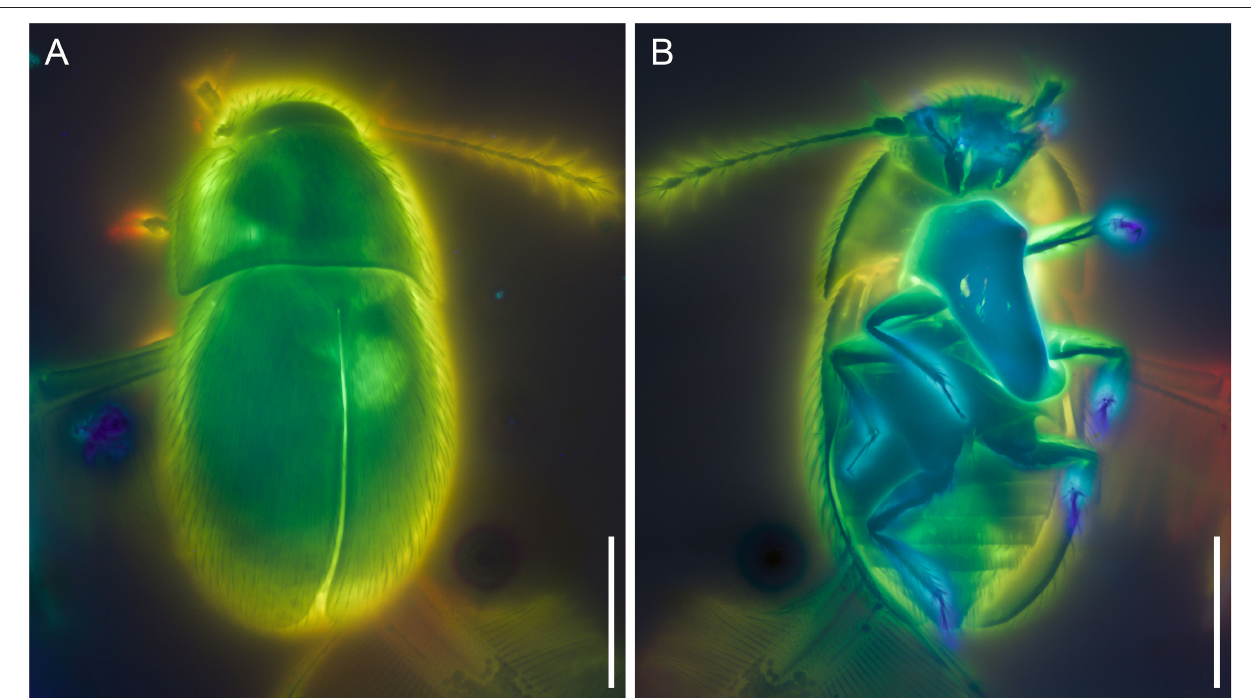
FIGURE 2 | Crenossidium slipinskii Li, Newton and Cai gen. et sp. nov. , holotype, NIGP180053, under confocal microscopy, with depth color coding. (A) Dorsal view. (B) Ventral view. Scale bars: 200 µ